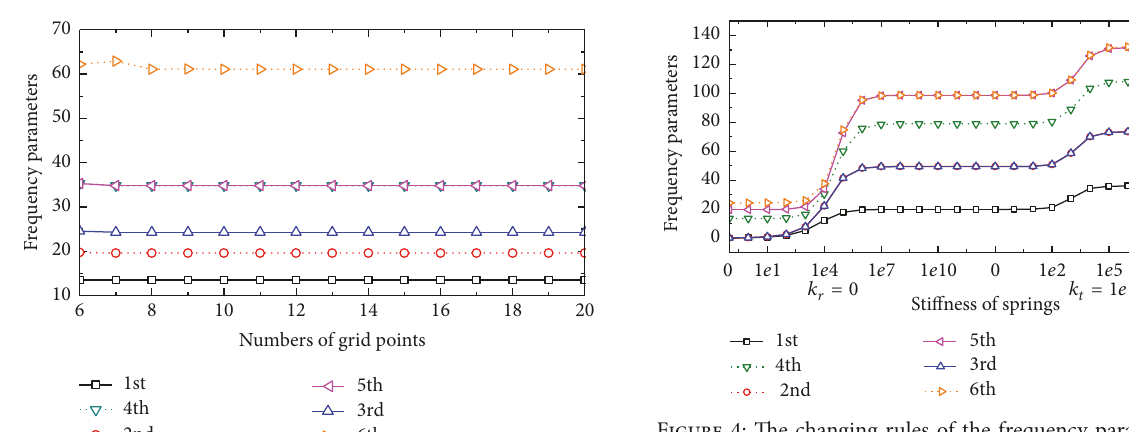
Figure 4: The changing rules of the frequency parameters as the stiffness of the element springs increasing.